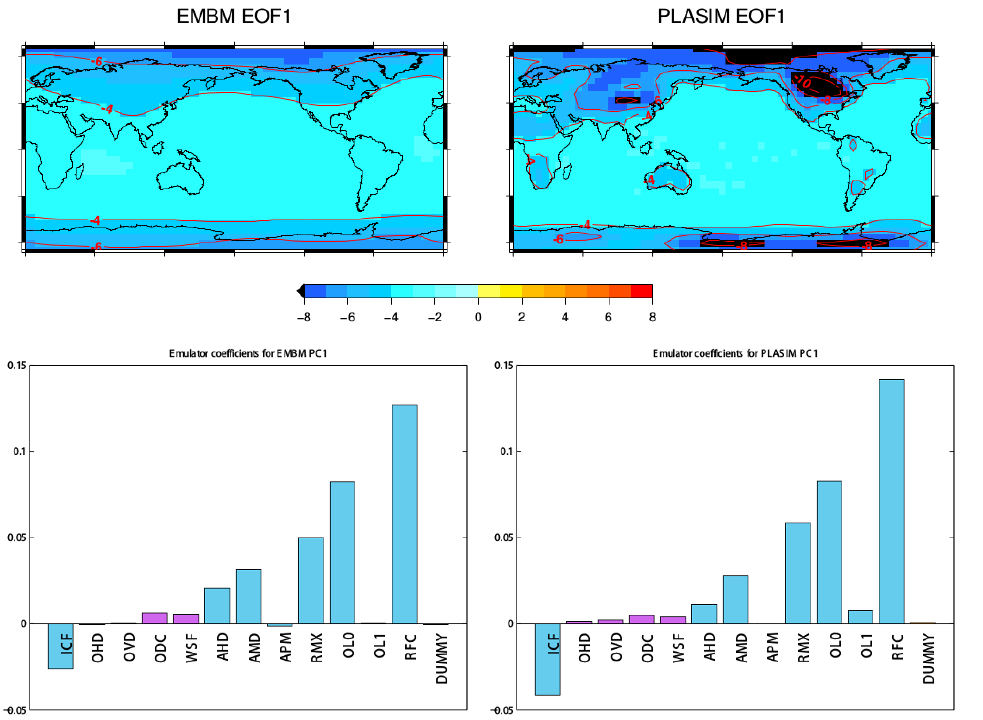
Figure 5. The first EOFs of EMBM and PLASIM SAT (upper) and the universal kriging emulator coefficients of their corresponding PCs (lower). All 600 data points are used to train each of these emulators. The black cells in PLASIM EOF1 indicate values lower than the plotted range. Contours are drawn over both plots at a 2 ◦ C